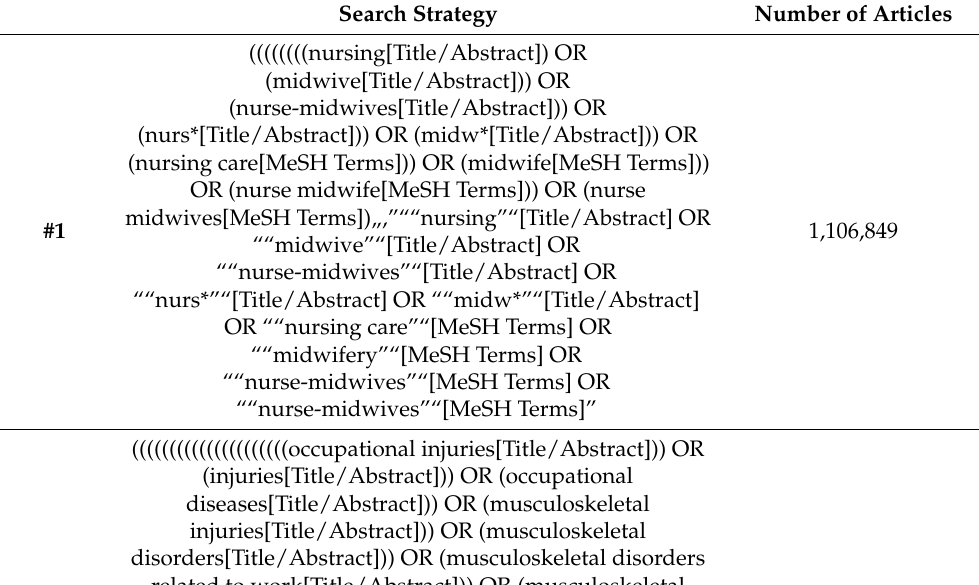
Table 1. Search Strategy. Lisbon,